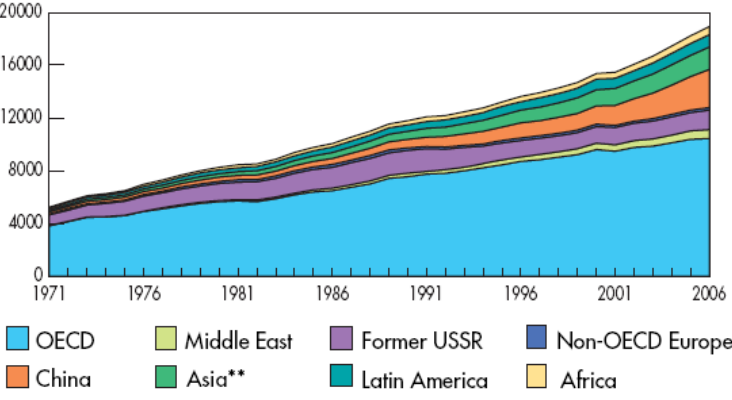
Figure 5. Evolution of electricity production (TWh) by region. Asia excludes